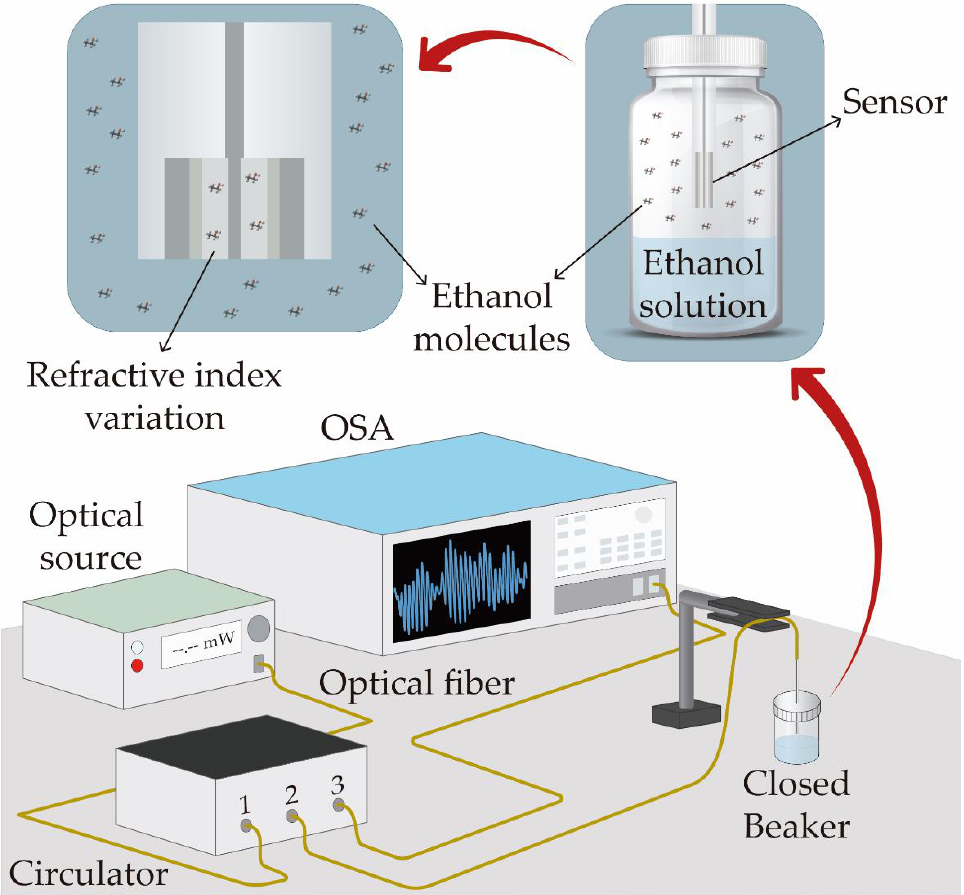
Figure 3. Schematic representation of the sensor characterization to different concentrations of gaseous ethanol. The insets depict the sensor when in the presence of VOCs molecules.